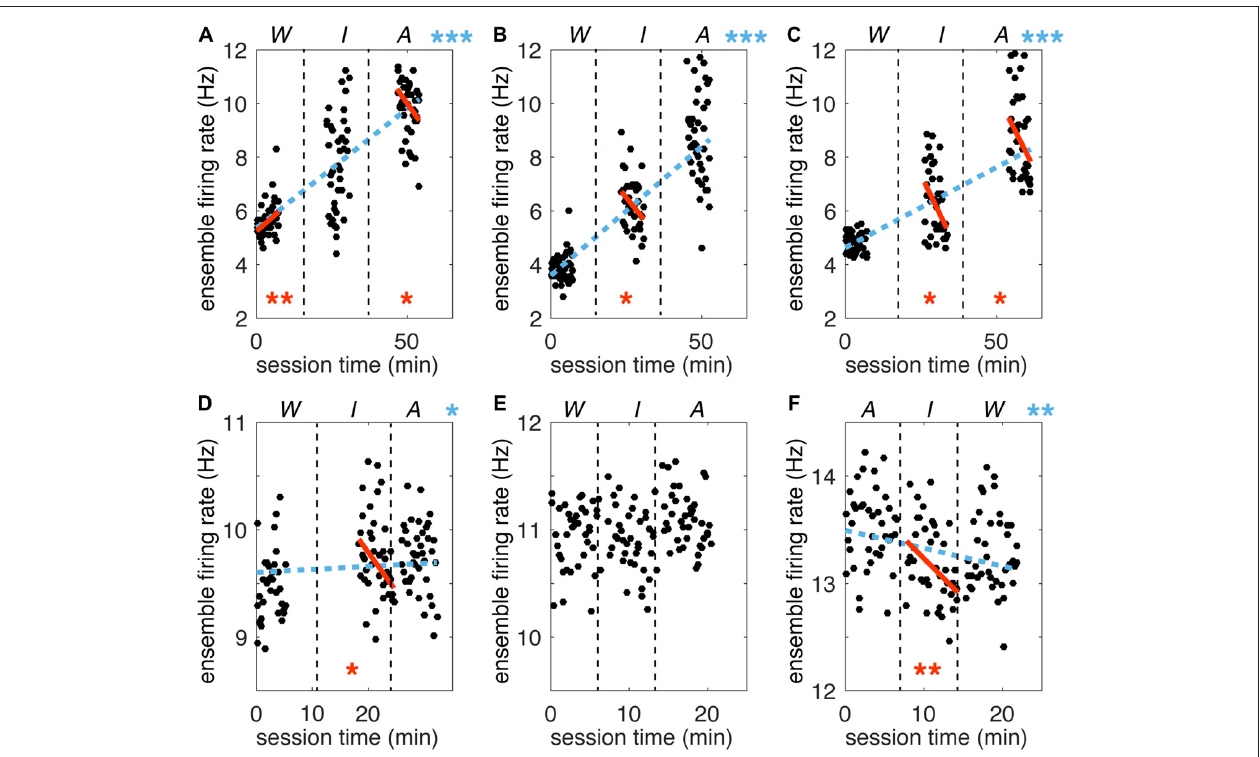
FIGURE 6 | Trends in ensemble firing rate across time. Ensemble firing rates (EFRs) for each trial (mean across all simultaneously recorded neurons) are plotted against total session time. (A–C) Sessions for participant S3. (D–F) Sessions for participant T1. Vertical dashed black lines separate VoS condition blocks, which are labeled above each plot (note reversed order of sessions in F ). Dashed blue lines represent the Theil-Sen slope estimate for the full session. Solid orange lines represent the slope calculated for each W, I and A block separately. Only slopes significantly different form zero are shown (Kendall’s Tau). Asterisks are used to indicate p values ( ∗ p < 0.05; ∗∗ p < 0.01; ∗∗∗ p <